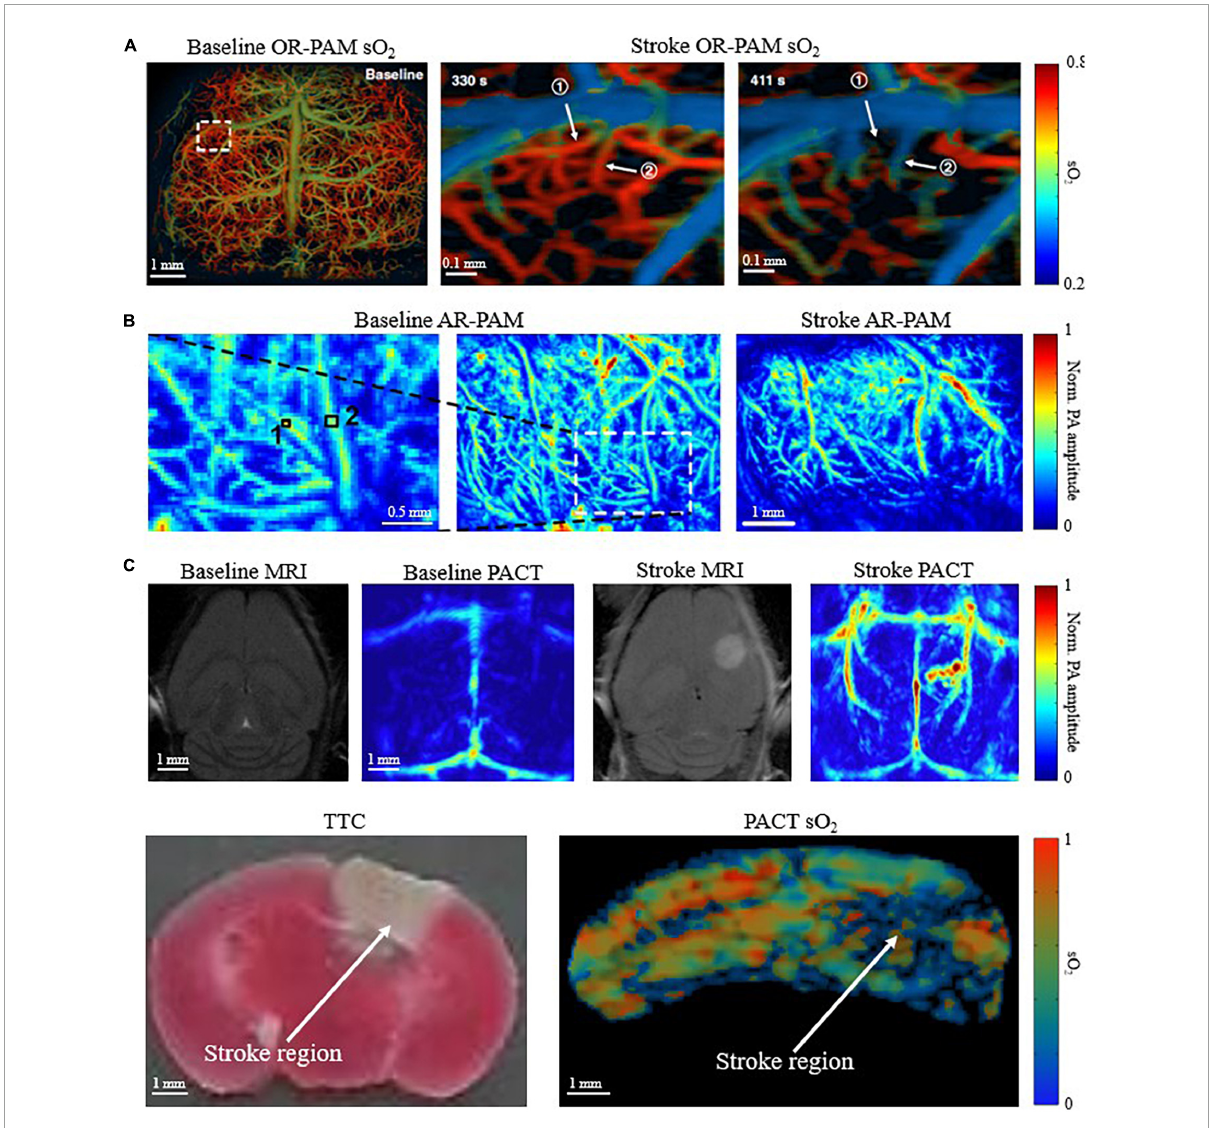
FIGURE3 Multi-scale PAI for small-animal stroke research. (A) OR-PAM oxygen saturation of hemoglobin (sO 2 ) image of mouse brain before stroke, 330s and 411s after stroke (skull removed) (Zhu et al., 2022). (B) AR-PAM image of mouse brain before and after stroke (skull removed) (Deng et al., 2012). (C) (Top) Baseline and post stroke MRI and corresponding PACT images of mouse brain. Infarct region in MRI corresponds with increased deoxygenated blood in PACT (scalp and skull intact) (Lv et al., 2020). (Bottom) Corresponding triphenyltetrazolium chloride (TTC) stained coronal slices and PACT sO 2 coronal images of mouse brain. Deoxygenated region in sO 2 image corresponds with infarct region identified by TTC (scalp and skull intact) (Menozzi et